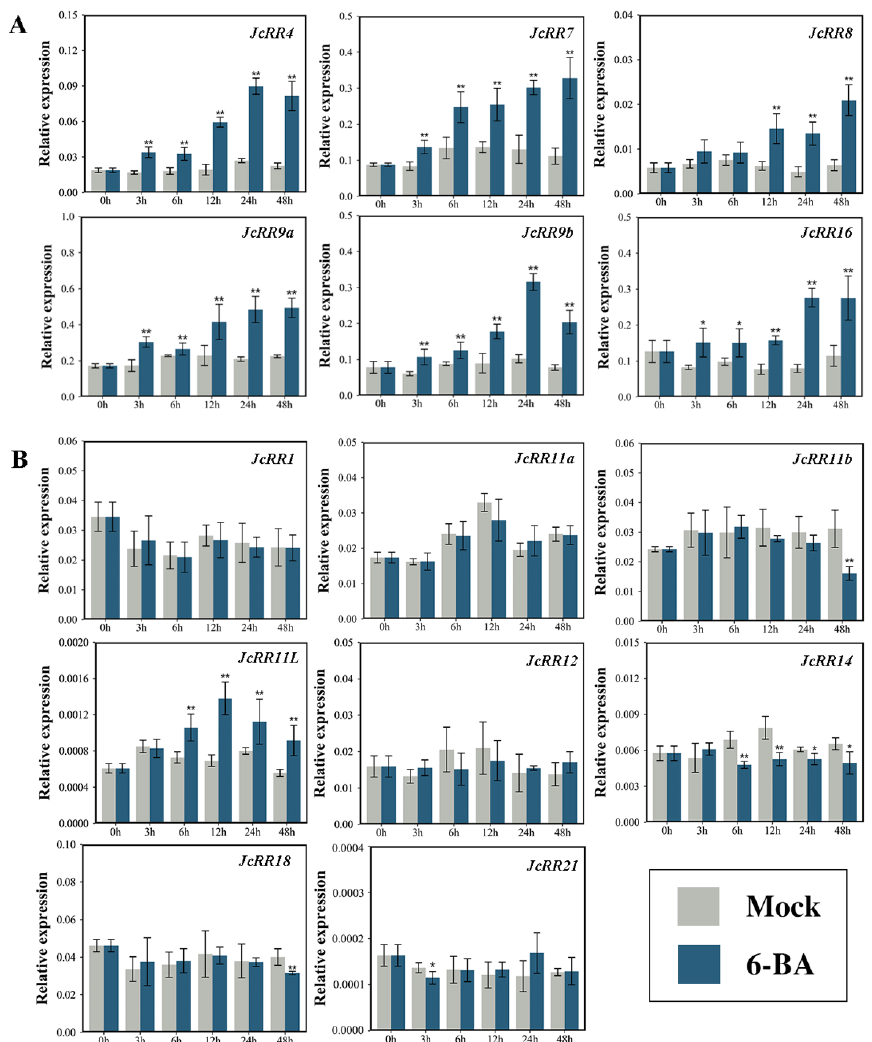
Figure 8. Expression profiles of JcRR s in response to exogenous 6- BA treatment, as revealed by qRT‒ PCR analysis. ( A ) Expression profiles of 6 type-A JcRR s. ( B ) Expression profiles of 8 type-B JcRR s. Samples were collected at 0 h, 3 h, 6 h, 12 h, 24 h, and 48 h after 6-BA (200 µM) treatment. The mock